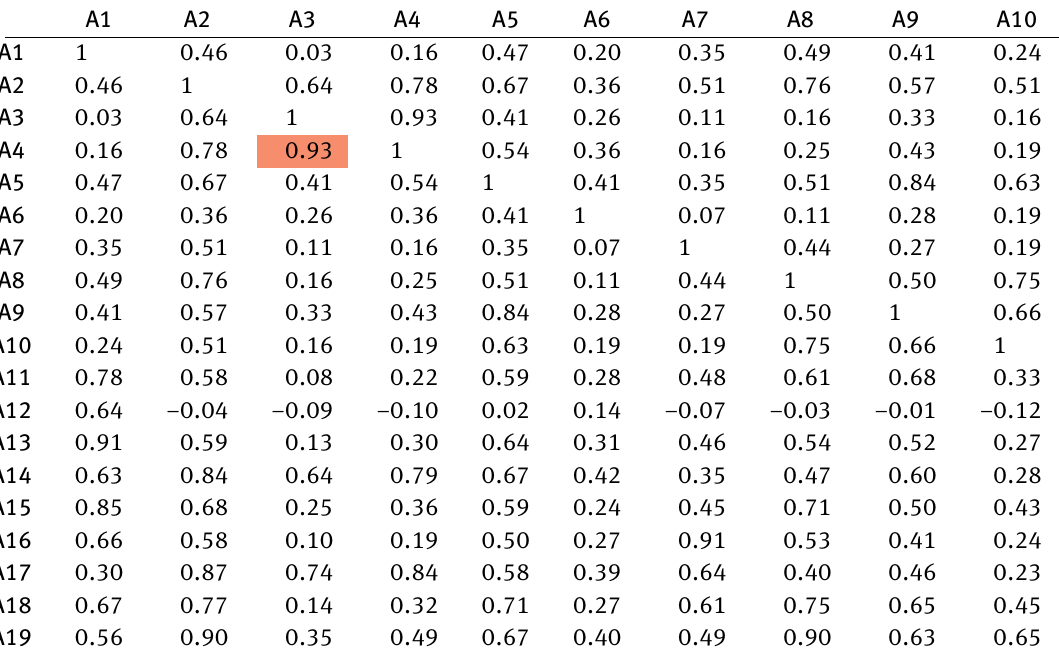
Table 4: Empirical correlations between original losses in adjacent areas, part